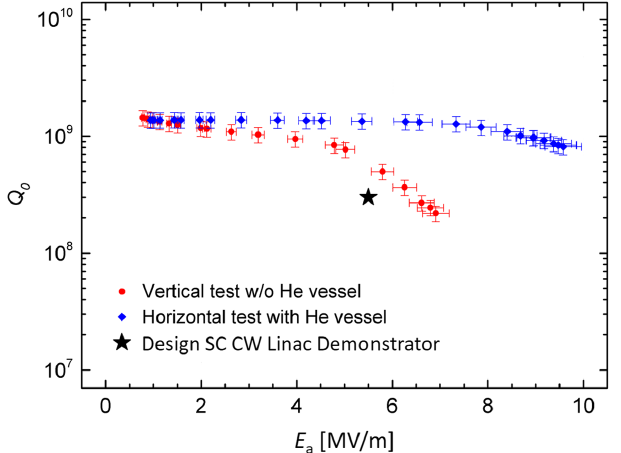
FIG. 5. rf test results of the SC CH cavity for the SC CW linac demonstrator at 4.2 K [16].